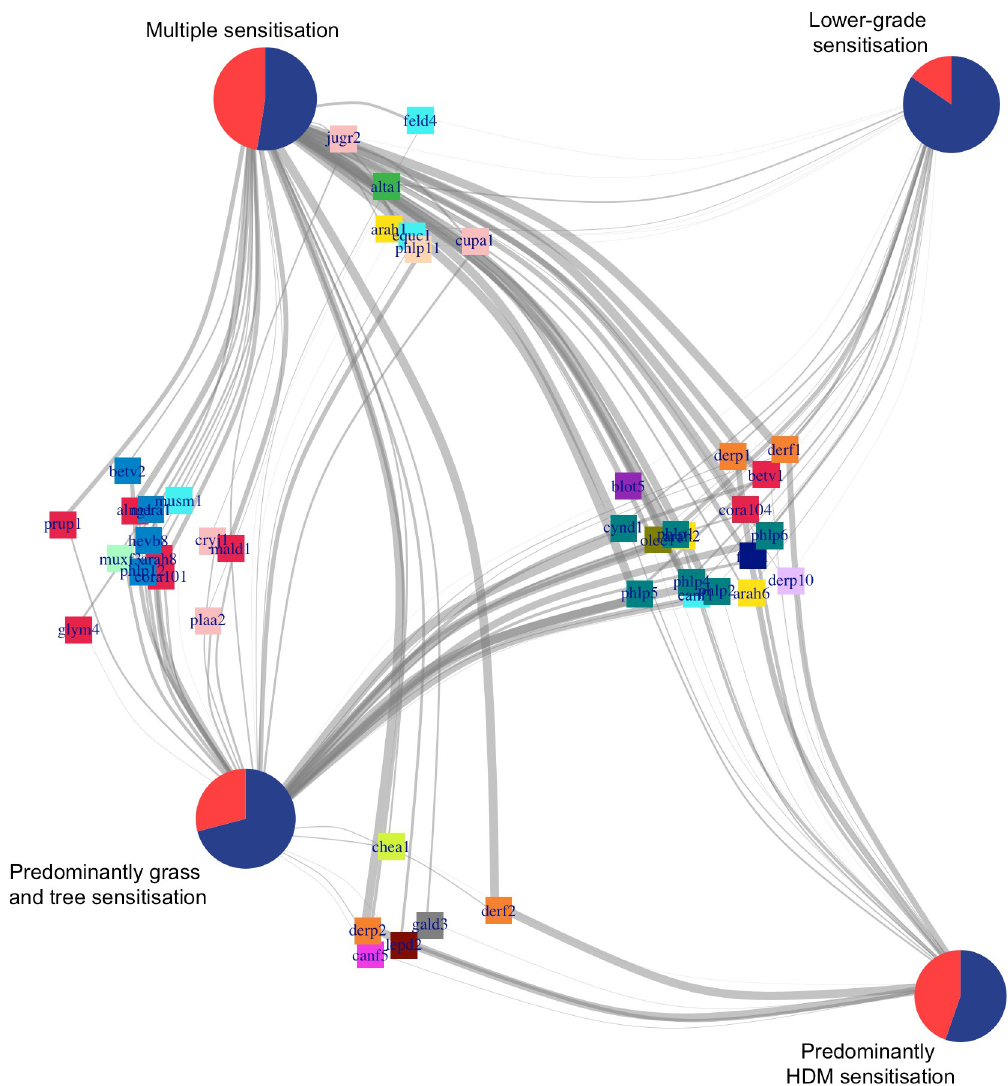
Fig 4. Bipartite network to uncover the relationship between sensitisation clusters and asthma, and the connectivity with component-specific IgEs and component clusters. In the bipartite network, nodes represent one or more types of entities, and edges between the nodes represent a specific relationship between the entities. Here, pie charts represent individuals aggregated according to sensitisation cluster membership and asthma status. Red indicates children with asthma, while blue indicates no asthma. Squares represent sIgE allergens and colours represent cluster membership. Edges show whether a subject has a positive response to a particular c-sIgE. MDS layout was used to infer the network. HDM, house dust mite; IgE, immunoglobulin E; MDS, multidimensional scaling; sIgE, specific immunoglobulin E.